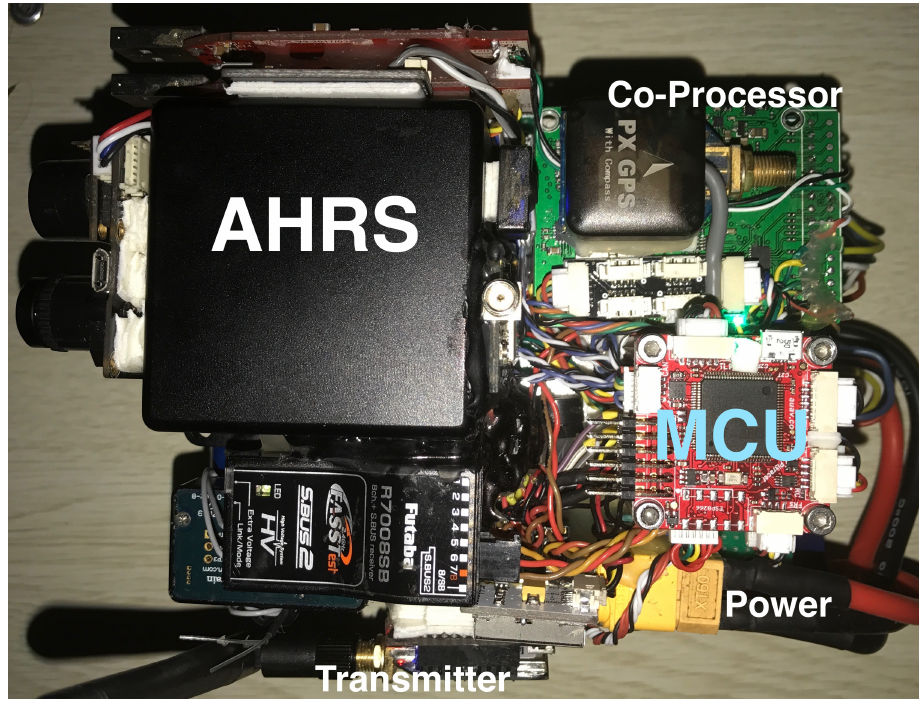
Figure 2. Designed hardware for the implementation of the